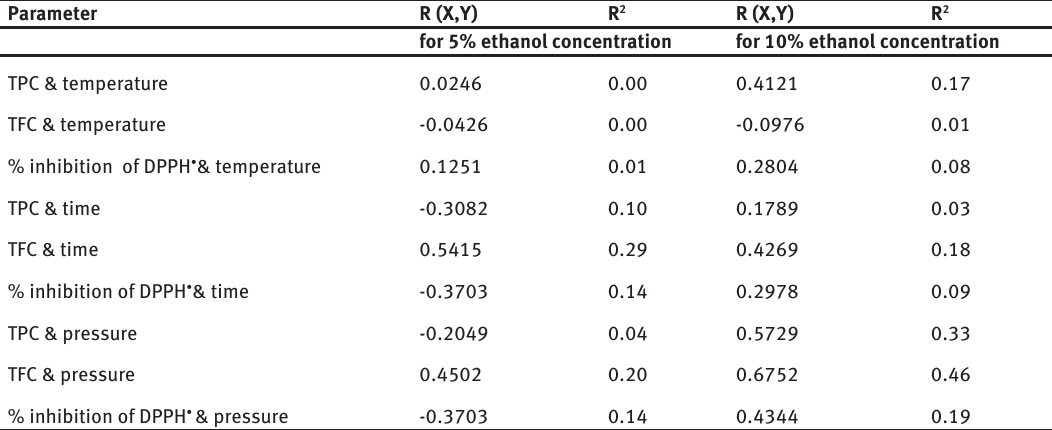
Table 8: Pearson correlation coefficients R (X, Y) and coefficient of determination (R 2 ) showing relationship between TPC, TFC, % inhibition of DPPH • , temperature, time and pressure for Tilia L. extract (Tiliae Inflorescentia). Parameter